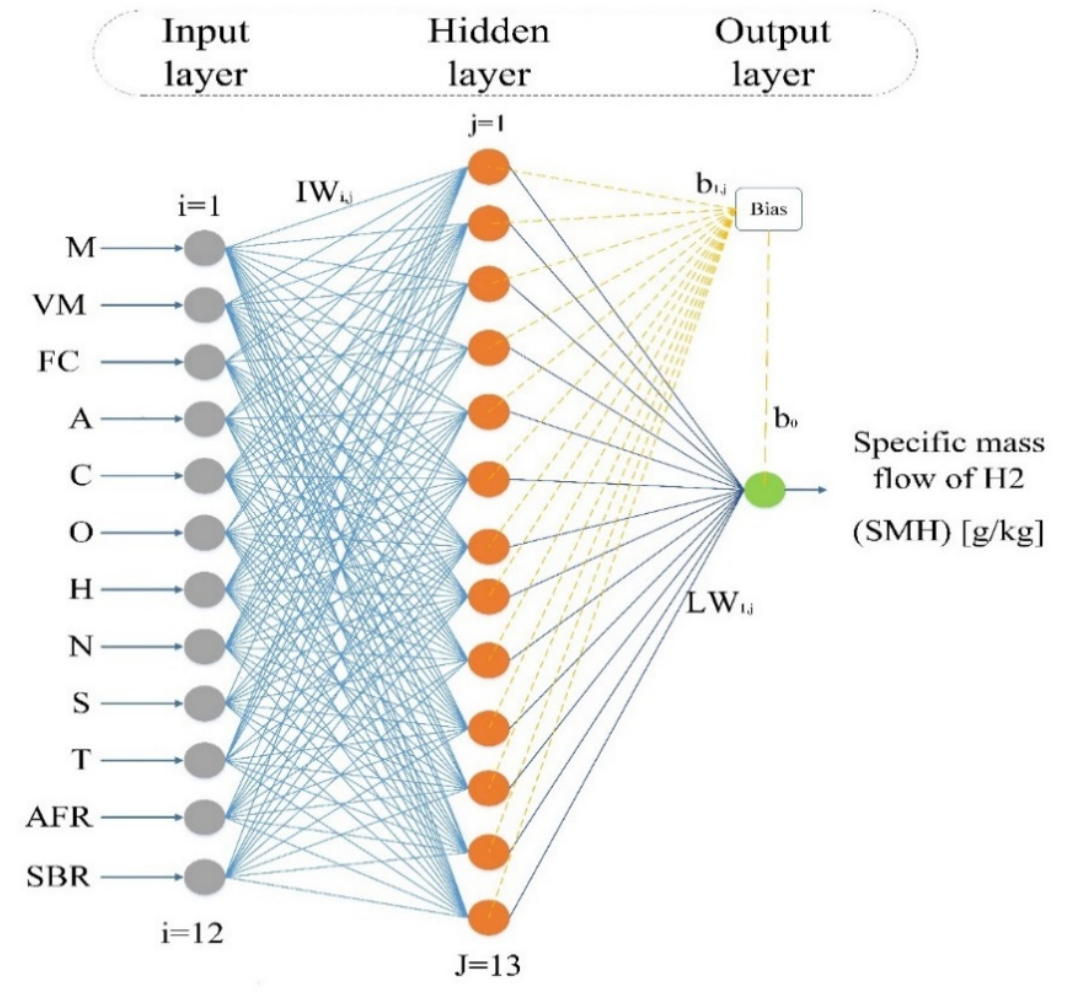
sm (g/kg) ( g/kg ) . . Figure 2. Structure of ANN for prediction of sm hydrogen hydrogen